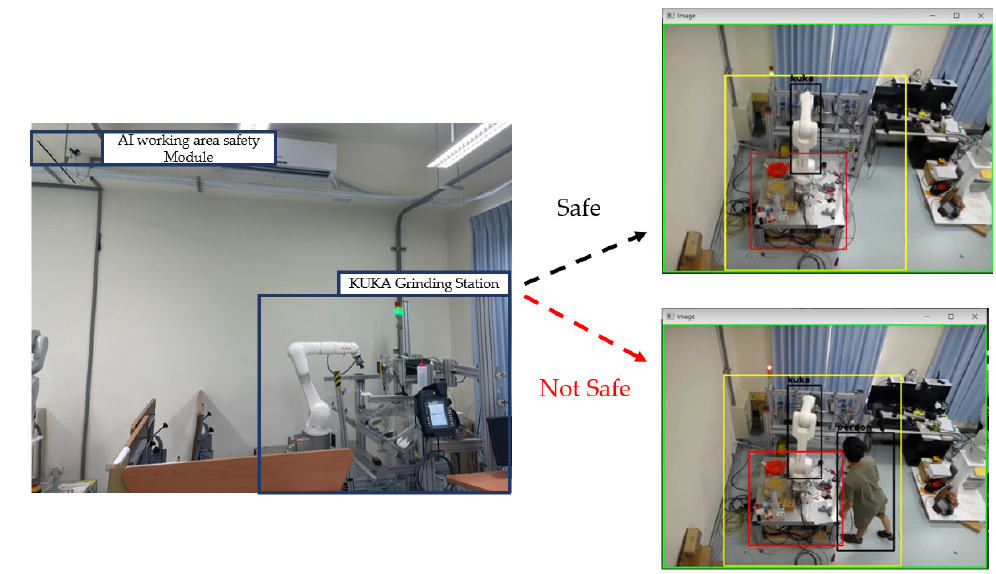
Figure 40. AI working area safety module action.